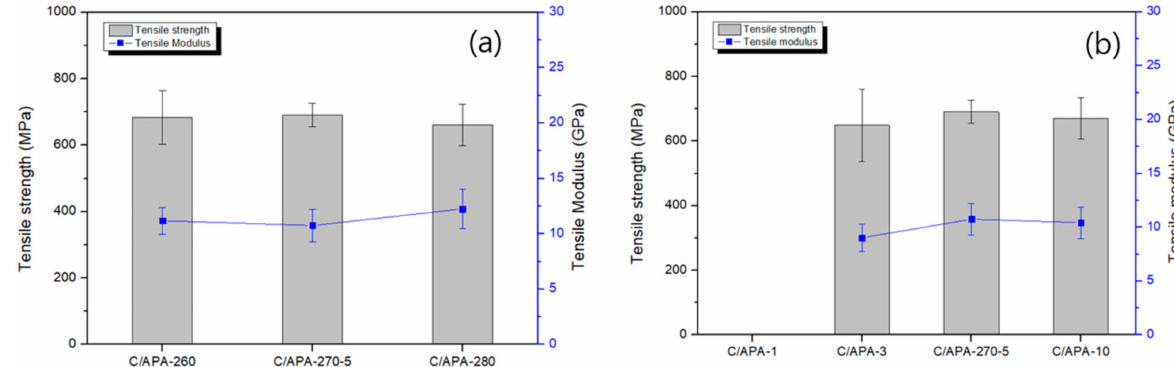
Figure 8. Tensile strength and modulus of Carbon/APA manufactured under different molding conditions: ( a ) molding time and ( b ) molding temperature.